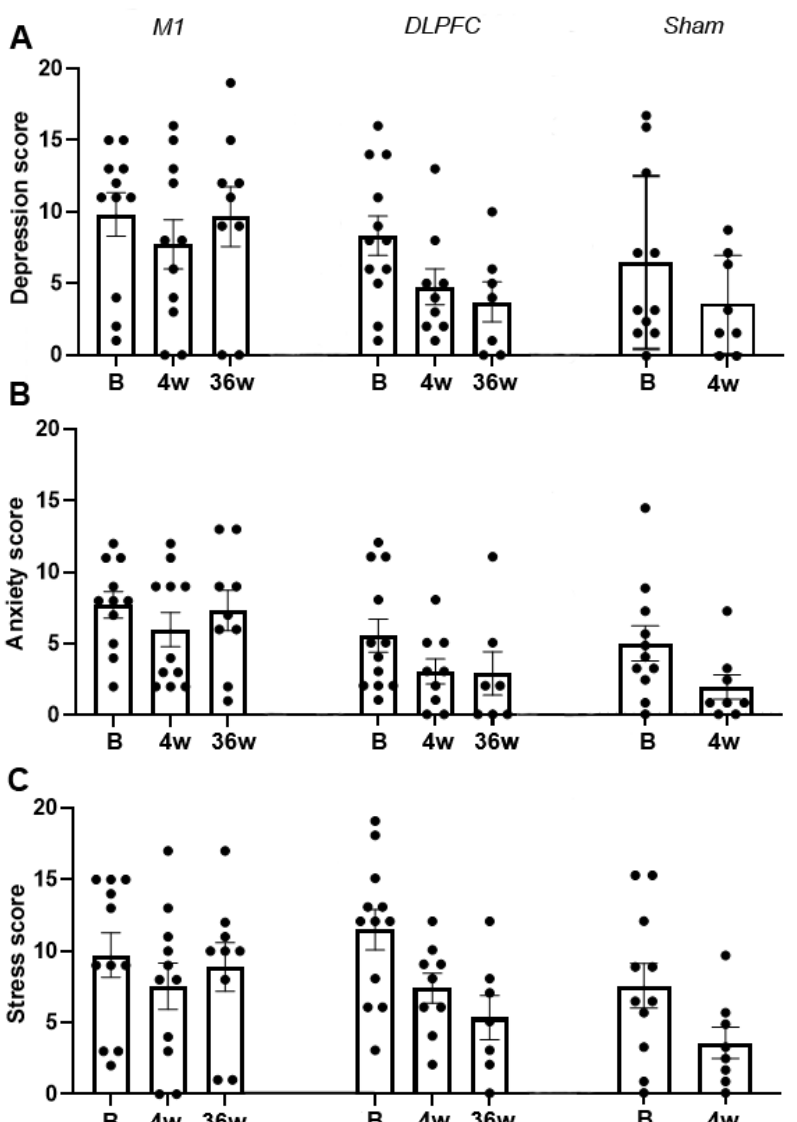
Figure 6. rTMS effects on DASS score for depression ( A ), anxiety ( B ), and stress ( C ). The y-axis indicates the mean score, and the x-axis depicts the time points (in weeks) of conducted measurements. Each dot shows the individual patients’ score. B = baseline; w = week; M1 = primary motor cortex; DLPFC = dorsolateral prefrontal cortex; Error bars depict the standard error of mean (SEM).